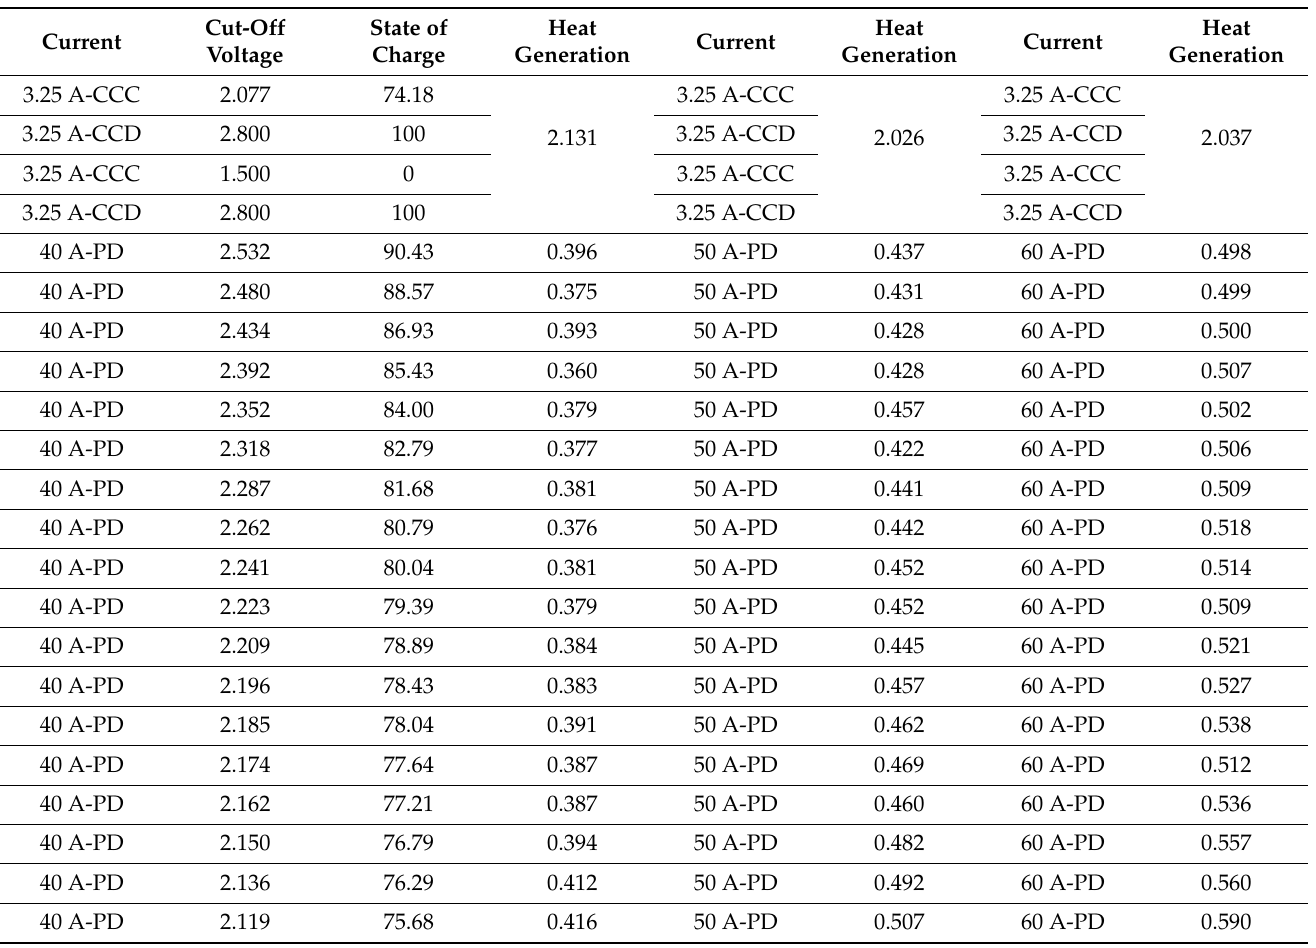
Figure 4. Thermal characterizations of a lithium titanate oxide-based lithium-ion battery, ( a ) heat generation evolution for case A, ( b ) total generated heat for case A. Table 4. Test matrix for Case